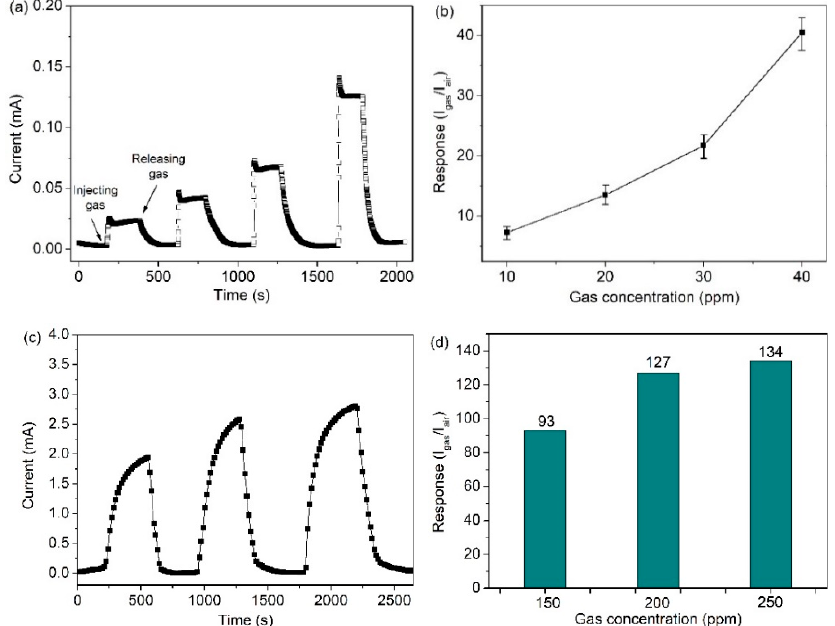
Figure 6. ( a ) Real-time gas-sensing curve and ( b ) the response performance of the sensor towards ethanol at concentrations of 10 ppm, 20 ppm, 30 ppm and 40 ppm. ( c ) Gas-sensing curves and ( d ) responses towards 150 ppm, 200 ppm and 250 ppm ethanol gas.